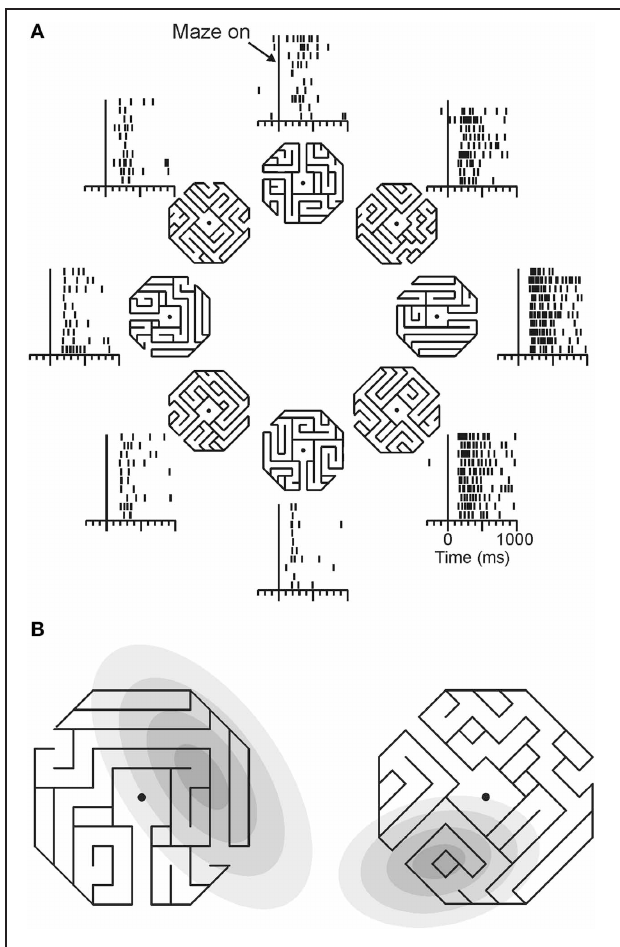
FIGURE 4 | Directional tuning of a parietal neuron during maze solution. (A) One maze stimulus was shown on each trial (mazes were 30 ◦ of visual angle across) centered on the gaze fixation target. Monkeys were trained to indicate whether the path that emanated from the center of the maze reached an exit or ended inside the maze. Only straight exit paths are shown in this figure. Each raster shows the neural activity of an area 7a neuron during trials in which the followed path pointed in the indicated direction. (B) The direction of the path emanating from the center of each maze indicates the preferred maze path of each cell. Gray ellipses indicate, in the same spatial scale, the locations of each cell’s visual receptive field, mapped with focal stimuli. Across the population, there was no concordance between receptive field location and preferred maze path